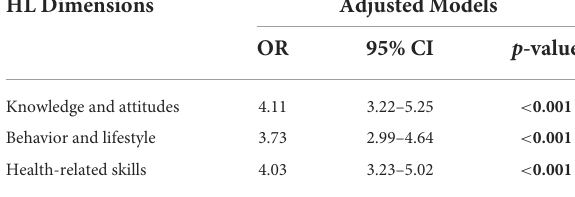
TABLE 4 Health literacy dimensions associated with COVID-19